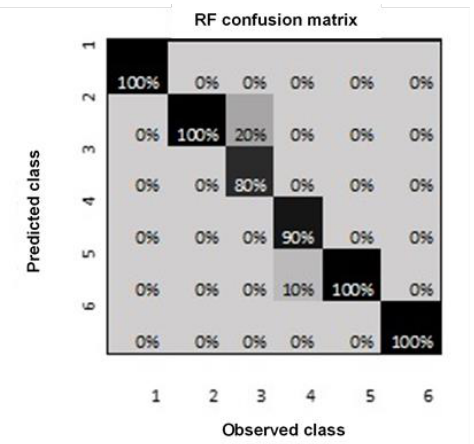
Figure 4. RF confusion matrix: (1) artificial territories, (2) agricultural, (3) forests, (4) bare areas, (5) water surfaces and (6) clouds.